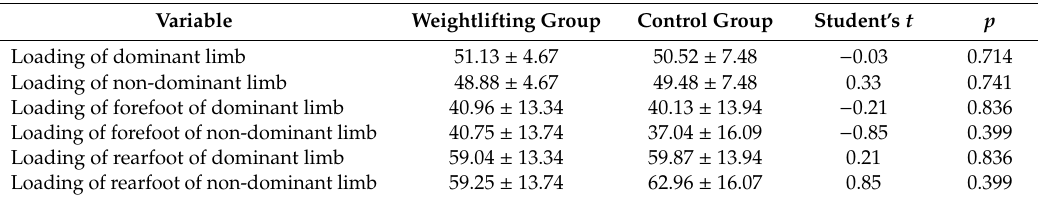
Table 3. Static forefoot and rearfoot plantar pressure of the dominant and non-dominant limb and between-group comparisons (Student’s t and p